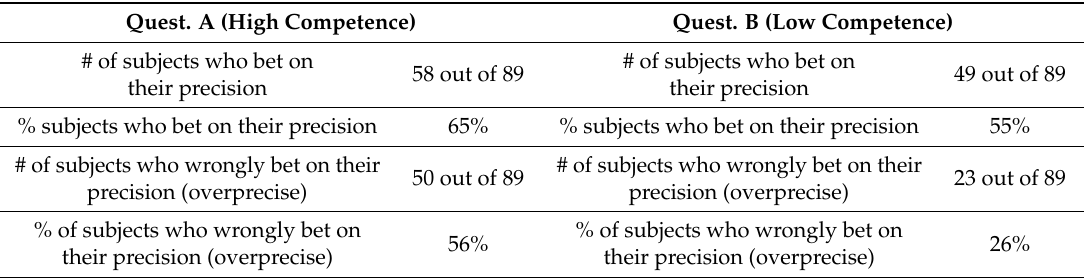
Table 3. The precision and perceived competence in the Self Selection